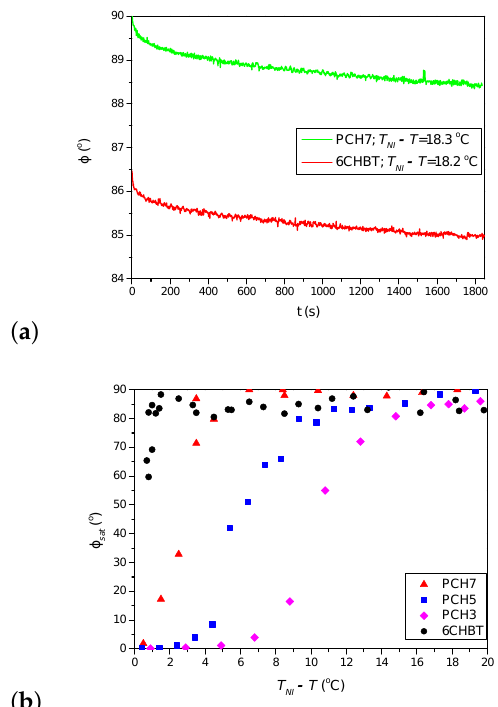
Figure 8. ( a ) Comparison of the back-relaxation of the azimuthal photoalignment angle, ϕ for 6CHBT and PCH7 at a relative temperature T NI − T ≈ 18 ◦ C as indicated in the legend (data for PCH7 taken from [17]). ( b ) Temperature dependence of the saturated azimuthal photoalignment angle, ϕ sat for 6CHBT and for the PCH homologous series (data for PCH NLCs taken from